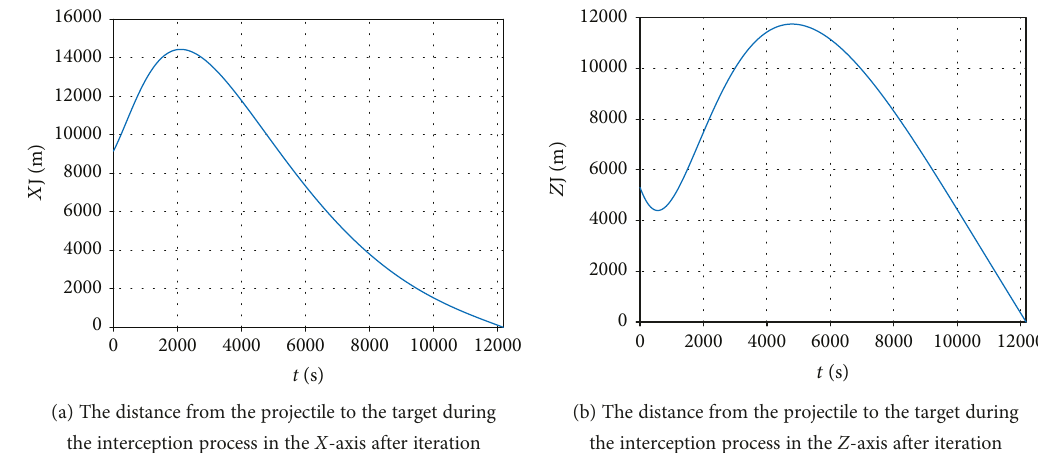
Figure 5: The distance from the projectile to the target during the interception process under the high-precision model after iteration.